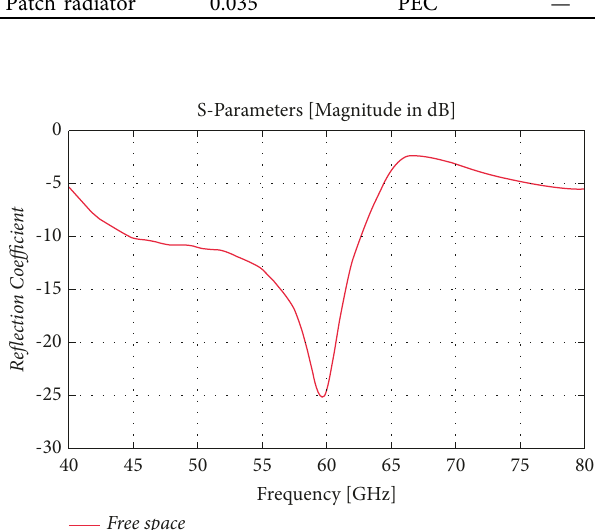
Figure 3: Return loss of the antenna in free space.